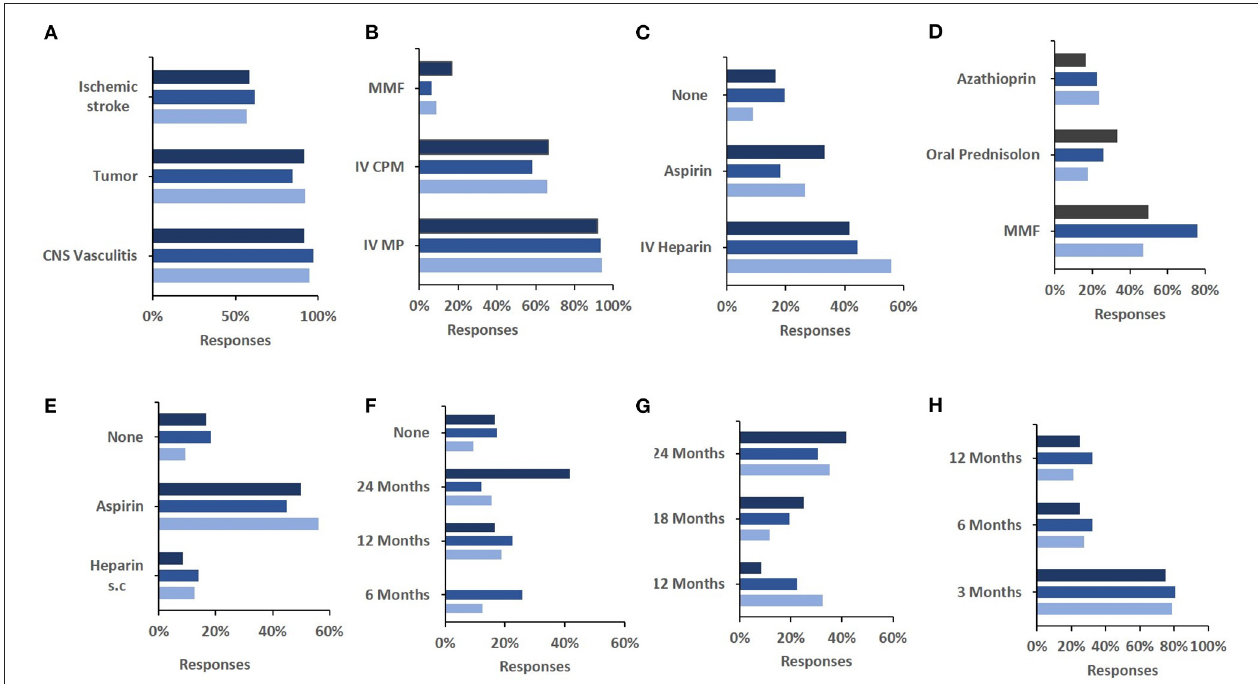
FIGURE 3 | Influence of experience of patients treated in their approach to diagnosis and treatment of the case study. (A) The correlation between number of sv-cPACNS patients treated and their differential diagnosis of the case study patient ( N = 12, 65, 37). (B) The number of sv-cPACNS patients treated agains induction treatment chosen ( N = 12, 62, 35). (C) The number of sv-cPACNS patients treated agains acute anticoagulation treatment ( N = 12, 61, 34). (D) The number of sv-cPACNS patients treated agains maintenance treatment ( N = 12, 62, 34). (E) The correlation between number of sv-cPACNS patients treated agains post acute anticoagulation maintenance treatment they would consider ( N = 12, 60, 32). (F) The number of sv-cPACNS patients treated agains duration of immune modulating maintenance treatment ( N = 12, 62, 34). (G) The number of sv-cPACNS patients treated vs. length of discontinuation of anticoagulation maintenance treatment ( N = 12, 58, 32). (H) The number of sv-cPACNS patients treated Vs. length of follow up ( N = 12, 62, 33). MMF, myophelolate mofetil; ASA, acetylsalicylic